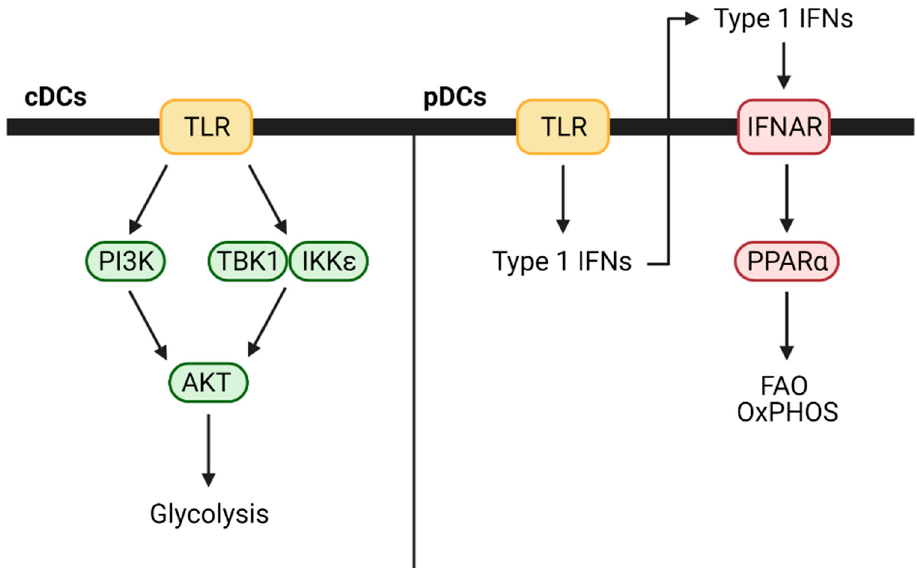
Figure 3. Metabolic changes that occur in DC subsets following TLR activation.IFNAR – interferon alpha-beta receptor; TLR – toll-like receptor.